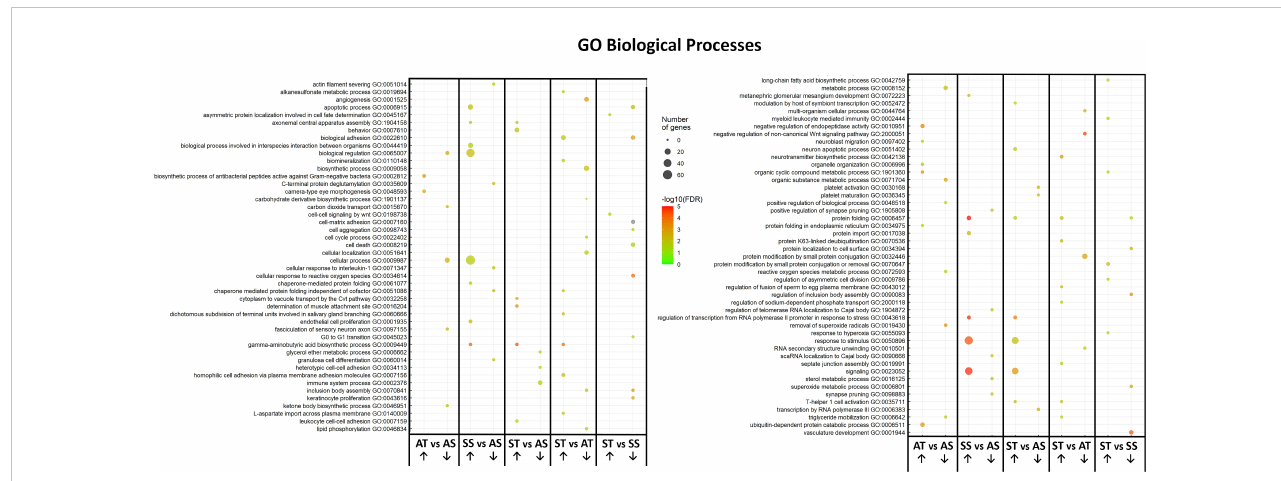
FIGURE 3 Changes in heart GO term pro fi le in response to TCAP or FSSW under ambient or stress treatments. The plots show the over-represented and most signi fi cant biological processes in the upregulated and downregulated DEG list in response to the treatments. The dot size indicates the number of DEGs associated with the process, and the dot colour indicates the signi fi cance of the enrichment [-log10 (FDR-corrected P -values)]. Upward-pointing arrows represent the upregulated GO terms, and the downward-pointing arrows represent the downregulated GO